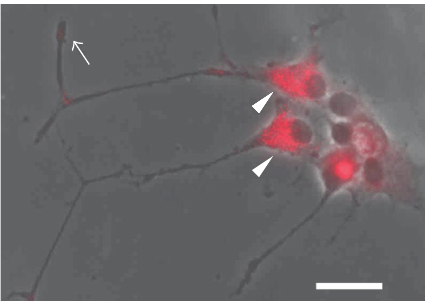
Figure 2: AT1R expression in a neuronal cell line. Immunohisto- chemistry for angiotensin II type 1 receptor (AT1R) in PC12D cells. Note that AT1R is detected in presynaptic terminal (arrow) or soma (arrow head). Scale bar: 20 μ m.